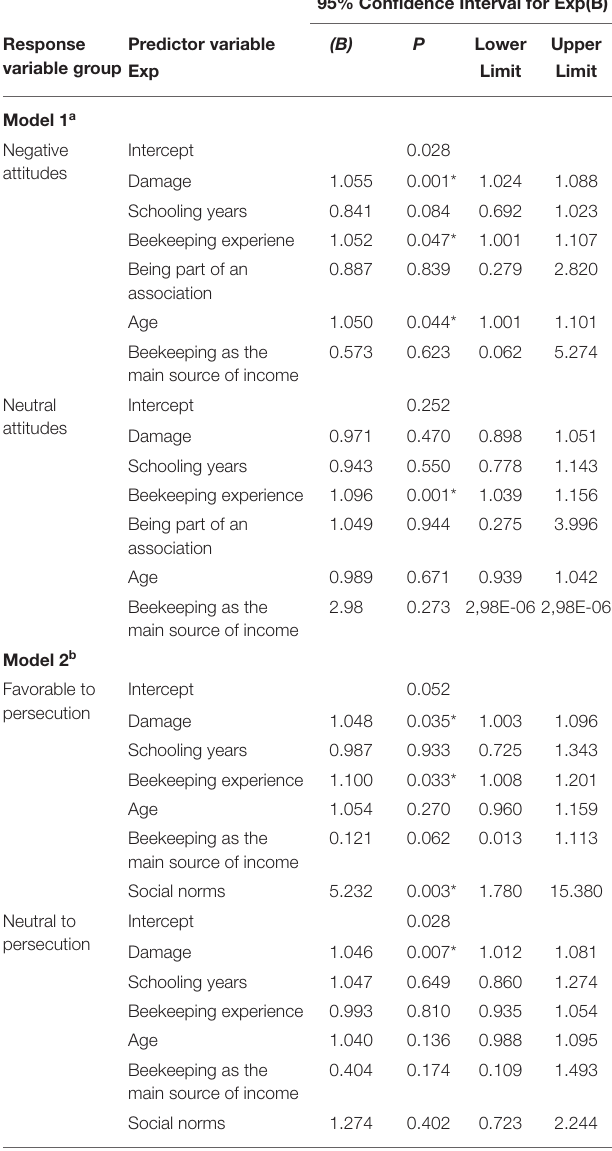
TABLE 4 | Multinomial logistic regressions of the association between beekeepers’ characteristics/experience and: (i) attitudes toward giant armadillos ( Priodontes maximus ) (Model 1) and (ii) attitudes toward their persecution (Model